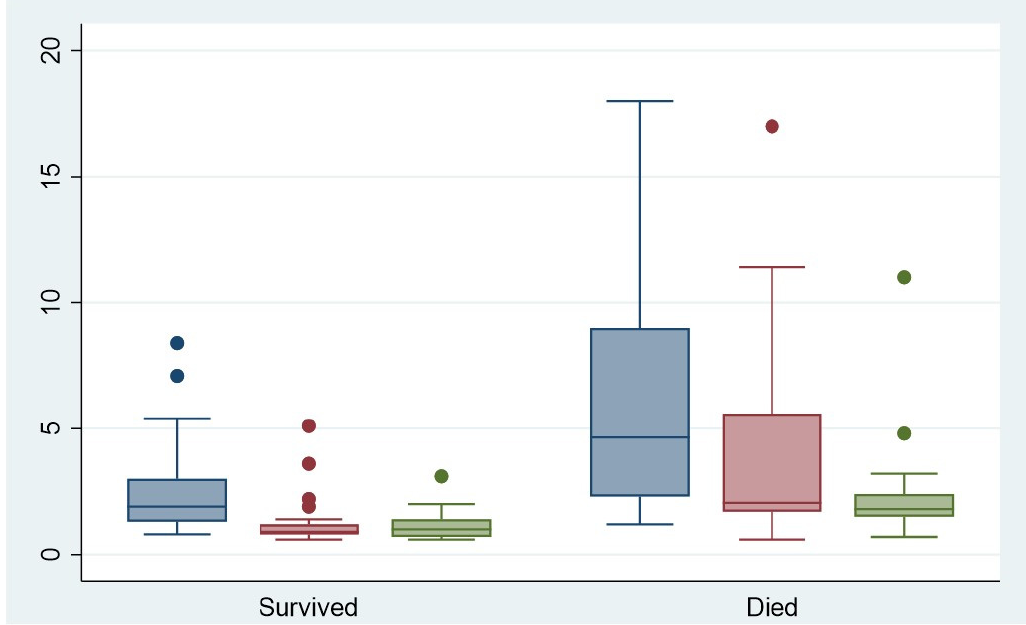
Figure 3. Serum lactate levels on arrival at hospital (blue), after 12 h (red) and after 24 h (green).